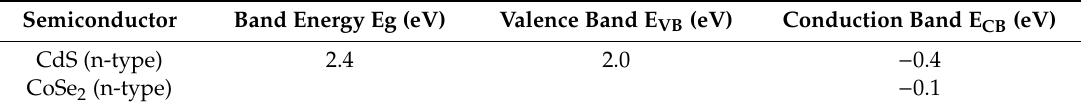
Table 1. Band gap energy, valence, and conduction band edge potential of CdS and CoSe 2 .